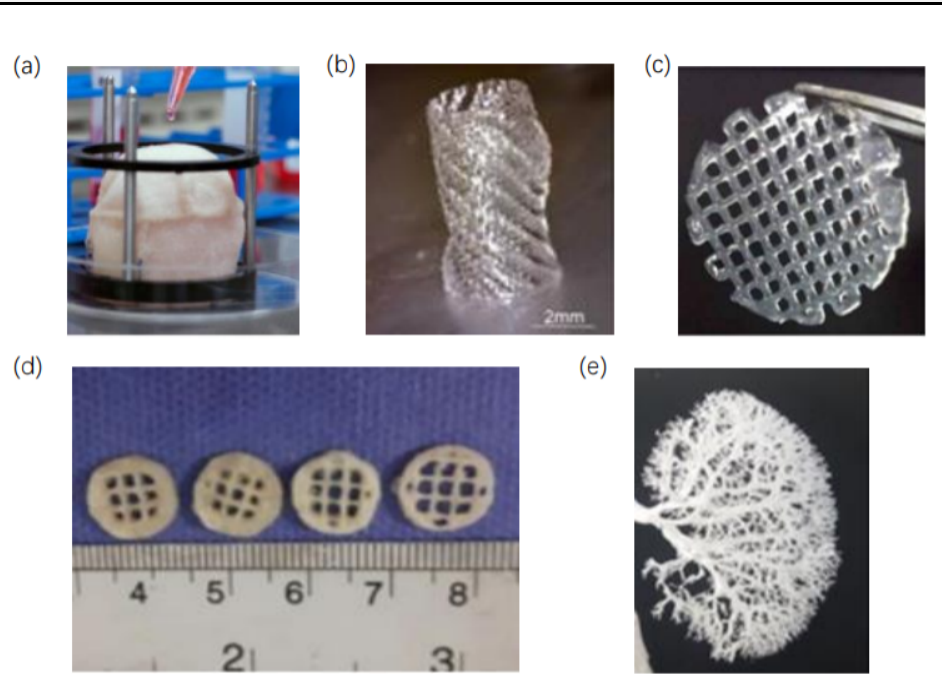
Figure 3. Examples of different urological tissues and organs fabricated by 3D bioprinting: ( a ) 3D- bioprinted bladder model [97]; ( b ) 3D-printed rabbit urethra [91]; ( c ) 3D-bioprinted decellularized